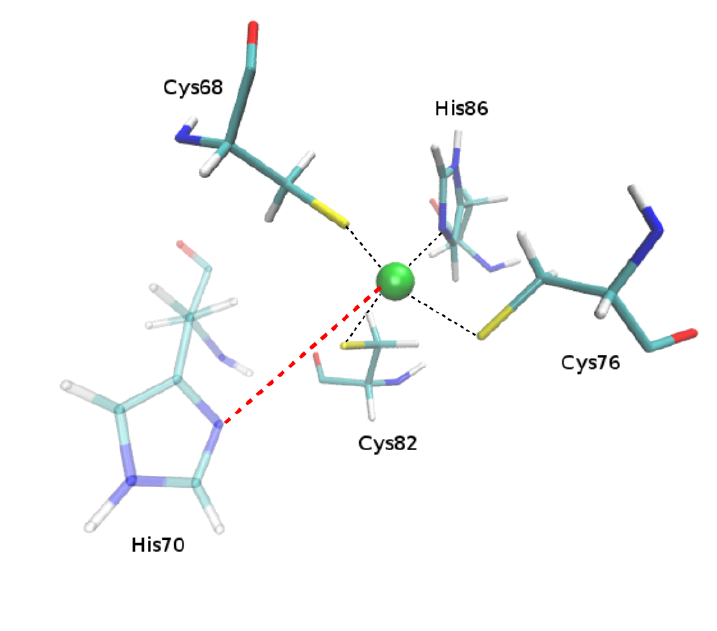
Figure 4. Putative new site discovered by 3D-PP. In the figure the residues that form the new site detected are shown. The green sphere represents the Zinc